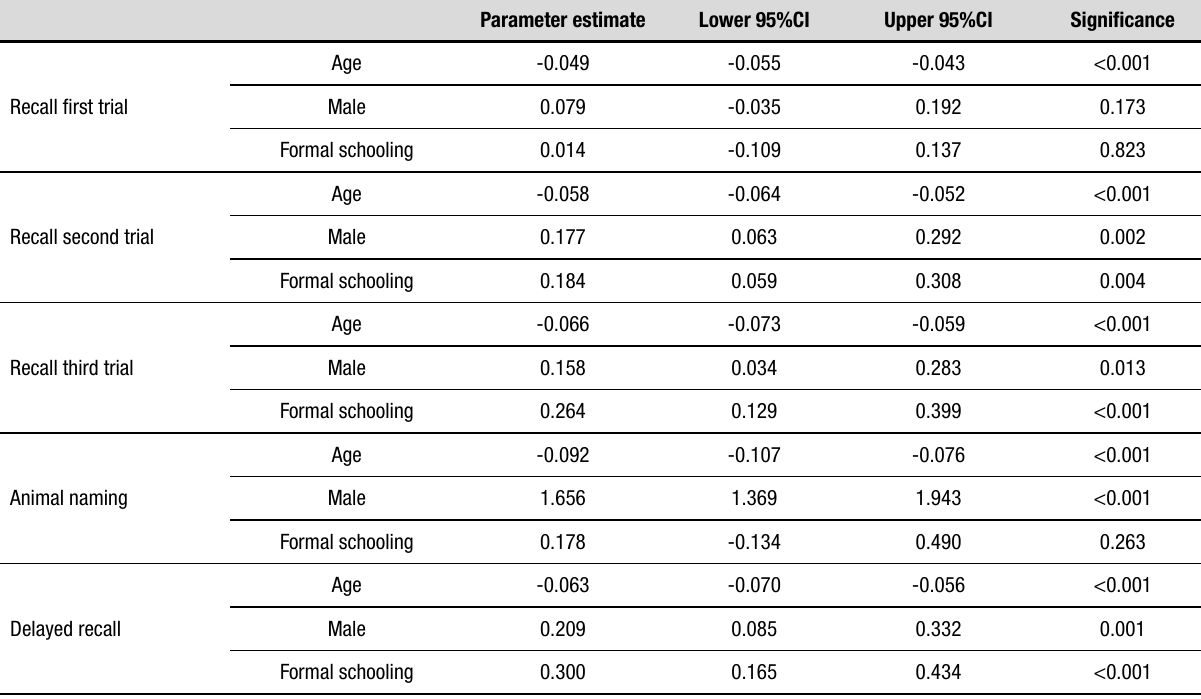
Table 5. Regression models for individual Identification of Dementia in Elderly Africans cognitive screen